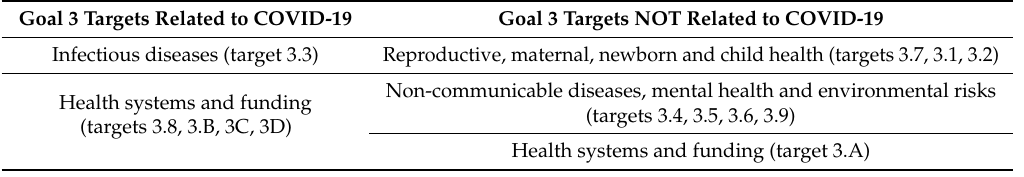
Table 4. Analysis of Sustainable Development Goal (SDG) 3 according to its relation to